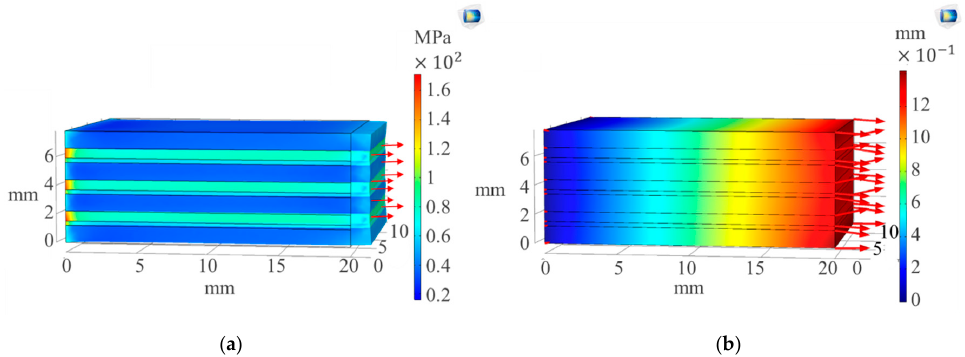
Figure 3. ( a ) Stress (MPa) concentration during loading and ( b ) the displacement (mm) of the composite.